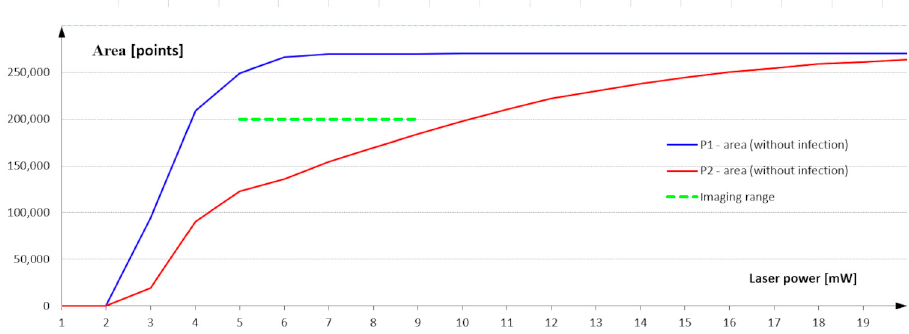
Figure 12. Measurement of surface area as a function of the laser power used to build a 3D image of the surface.